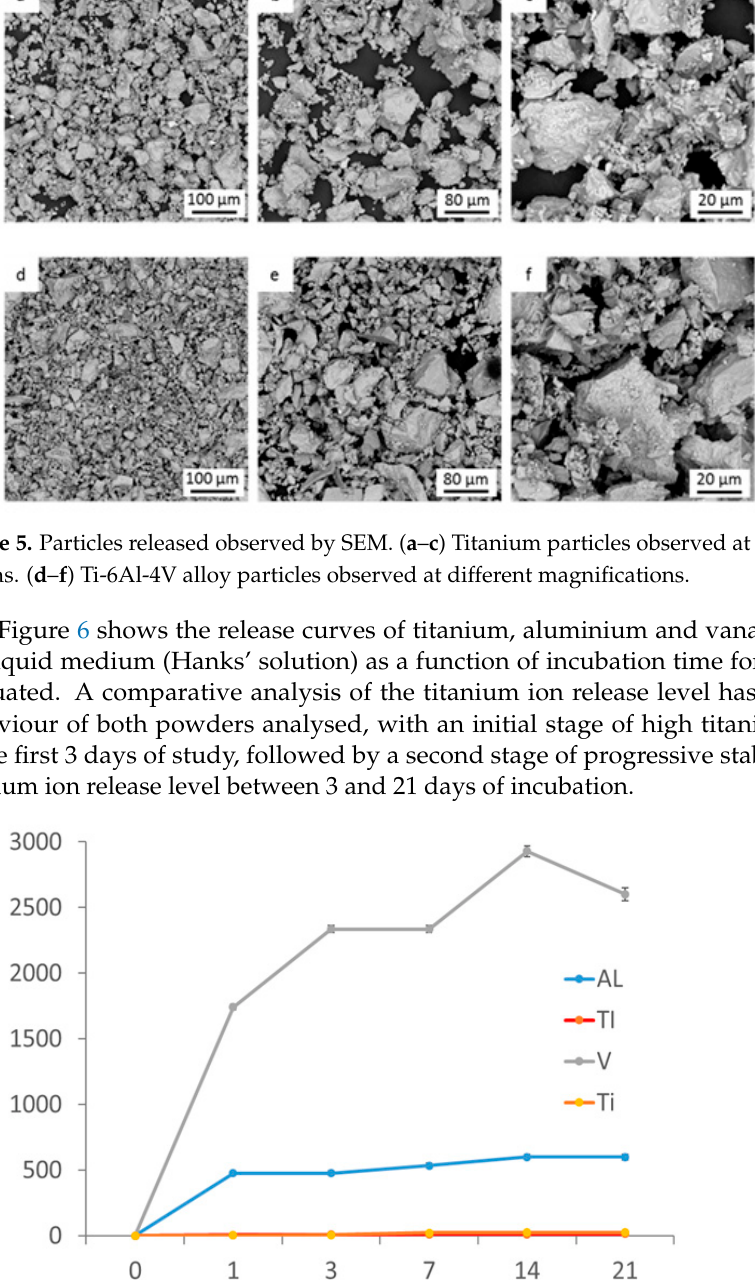
Figure 7. Cellular viability in the cytotoxicity tests: ( a ) SAOS–1 and ( b ) HFF–1. Cytotoxicity tests have shown values slightly above 80% cell survival in both cell lines tested for the Ti–15 μ m powder. However, the Ti6Al4V powder showed mean cell survival values below 80% for the HFF – 1 cell line. In view of the results, a certain tendency towards an increased cell cytotoxic effect on human fibroblasts (gingival tissue) of Ti6Al4V powder particles compared to titanium particles is confirmed. A cytotoxicity as- say was also performed for THP–1 cells at 24 and 48 h to assess cell survival. For this, these cells were cultured in medium containing the extracts at different concentrations: [ISO] (0.2 g/mL), and their dilutions 1:2, 1:10, 1:100 and 1:1000. According to regulations, a cell